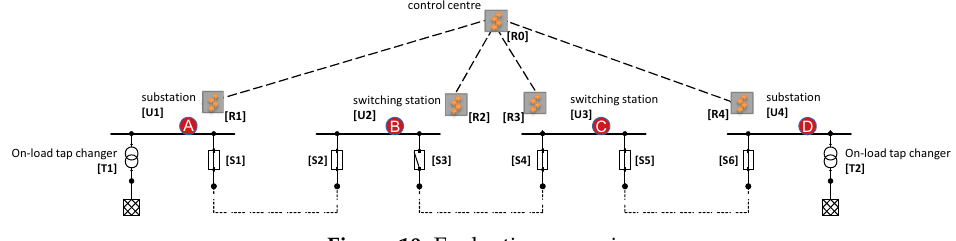
Figure 10. Evaluation